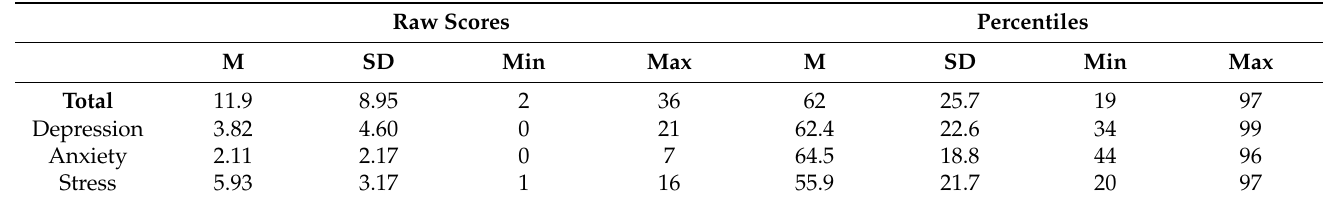
Table 2. A detailed description of the DASS-21 with subscale scores for depression, anxiety and stress. Scores reported in raw form and converted into percentiles based on normative data [48].